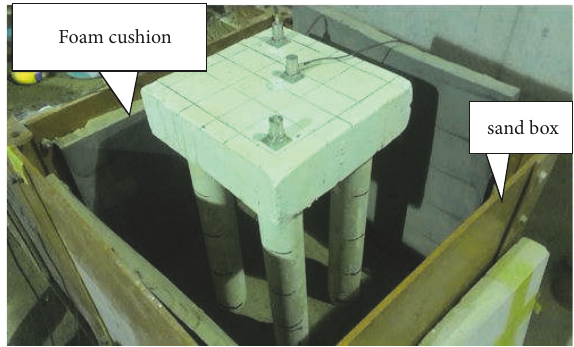
Figure 2: Laboratory test sand